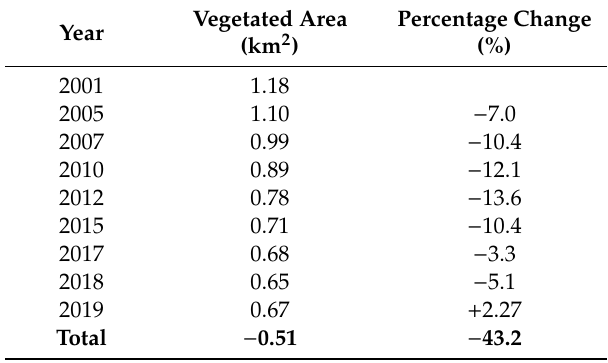
Table 2. Change in dune area on the coastal barrier from 2001–2019.